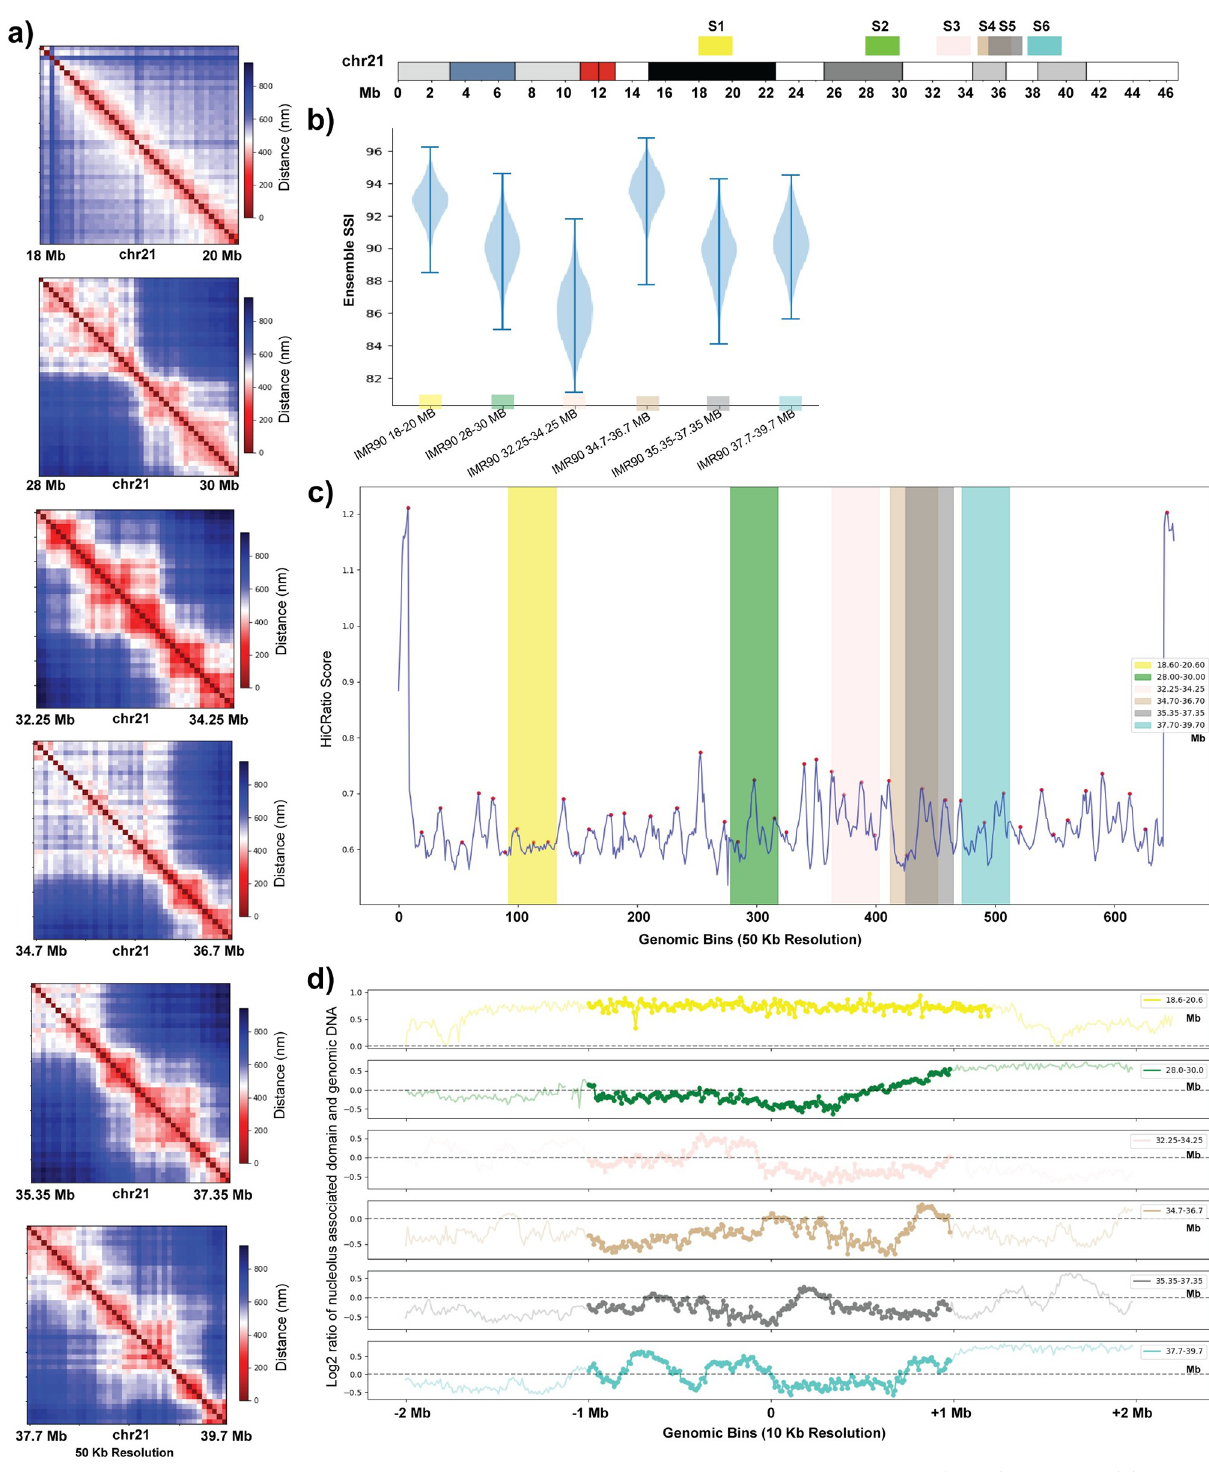
Fig 5. Evaluation of structural variation of regions with different epigenetic, genomic, and structural properties. a) Population-averaged distance maps of 6 different genomic regions of IMR90 chr21 at 50 kb resolution obtained from Su et al . [38]. Locations of these 6 regions are indicated on the top right chromosome ideogram and labeled with colors used throughout the figure. b) Chromosome structural ensemble SSI distributions for the same 6 regions of IMR90 chr21. For resampling, 300 single-cell structures are selected randomly each time. c) HiCRatio score of each genomic bin of chr21 q- arm at 50 kb resolution (calculated with a 300 kb window size). The red points represent the boundary positions inferred by HiCRatio. d) Nucleolus